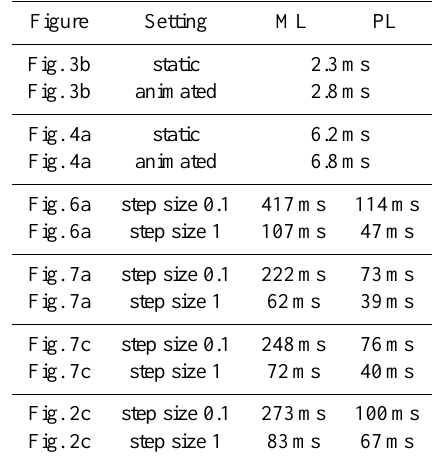
Table 2. Order of magnitude of rendering times achieved by Met.3D for selected visualizations from this paper. Timings are measured on the test hardware described in Sect. 3. ECMWF ENS data at a grid spacing of 1 ◦ in both longitude and latitude are used. The data fields are available in GPU memory. ML refers to visualizations from hy- brid sigma-pressure model levels (62 levels), PL refers to visualiza- tions from data fields regridded to 62 pressure levels chosen equal to the levels of an ML grid defined by a constant surface pressure of 1000hPa. Timings are average values of continuous rendering over 30s. A Met.3D window of 1600 by 900 pixels is used (the size used for the video in the Supplement, corresponding to a viewport of 1192 by 864 pixels). “Animated” for cross sections refers to verti- cally sliding a horizontal section or moving a waypoint of a vertical